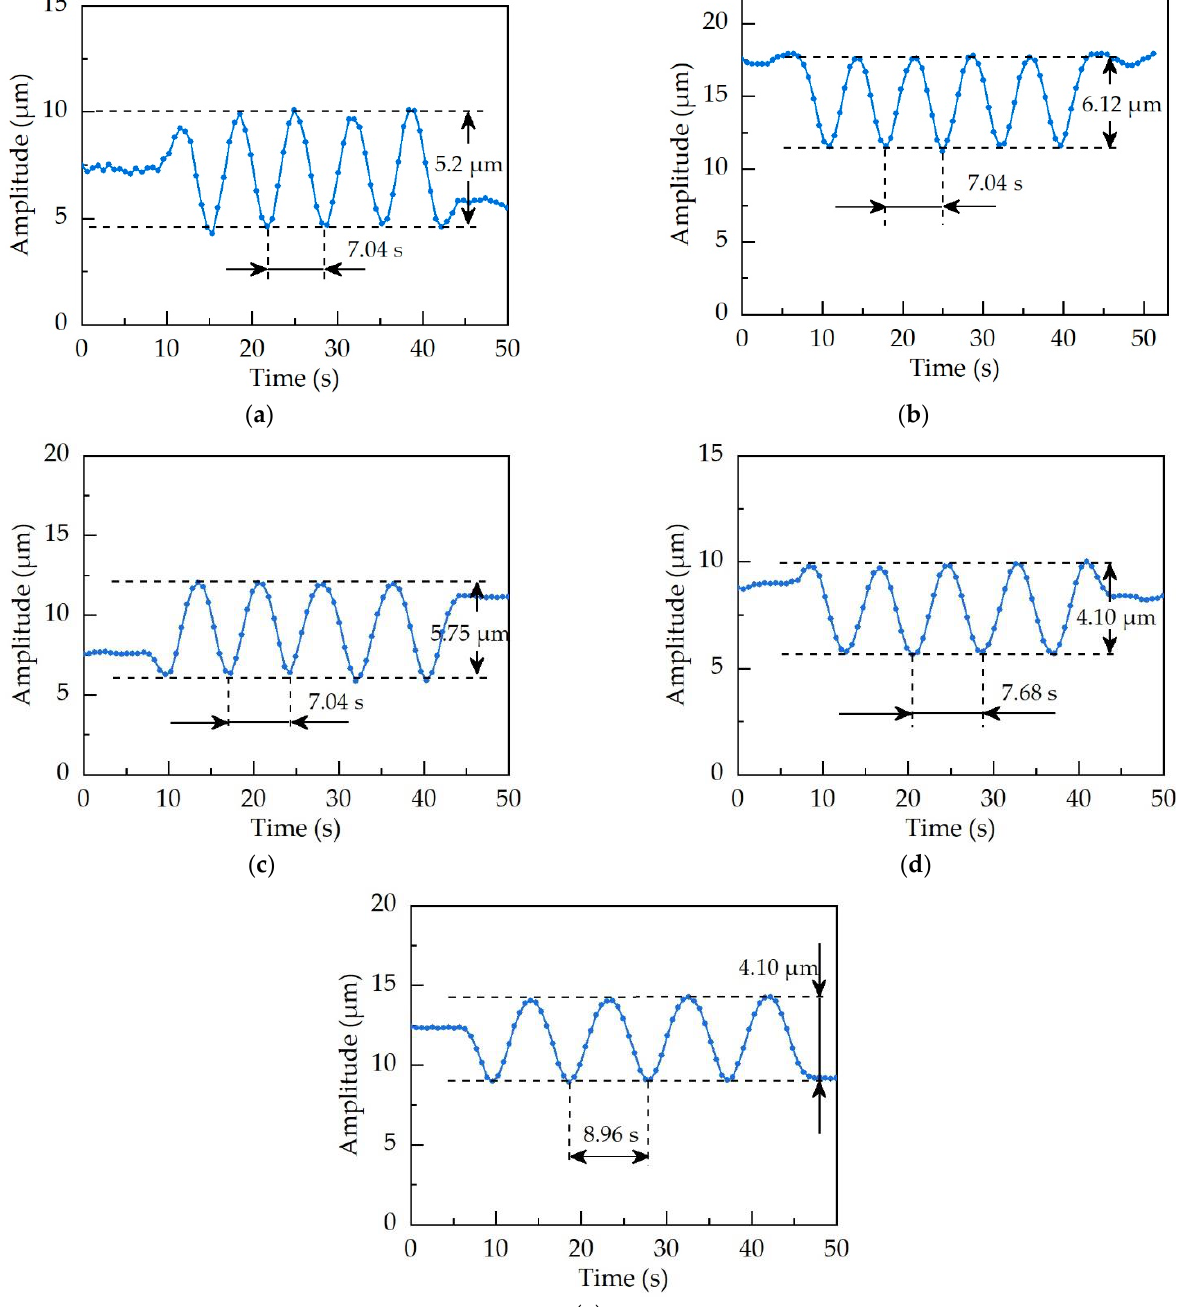
Figure 17. The amplitude curve of spindle vibration of 1X frequency. ( a ) Rotation speed of 350 r/min; ( b ) rotation speed of 800 r/min; ( c ) rotation speed of 900 r/min; ( d ) rotation speed of 1000 r/min; ( e ) rotation speed of 1100 r/min.